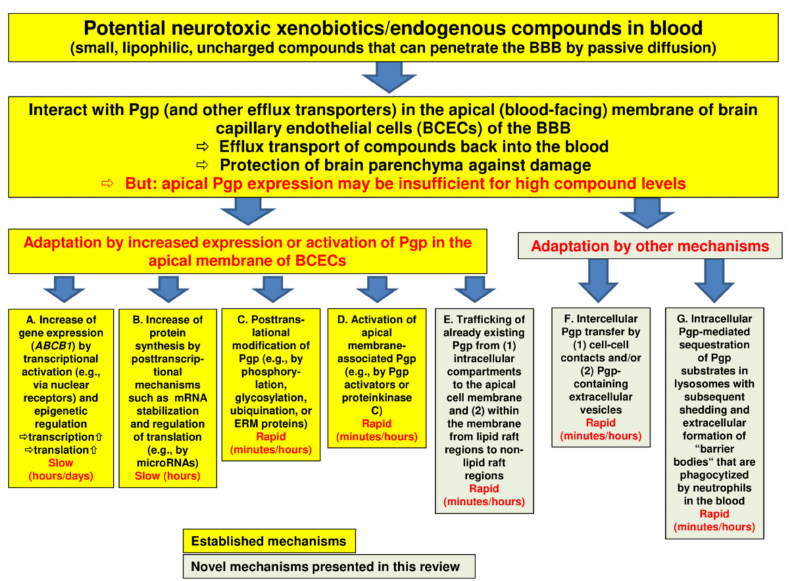
Figure 1. Regulation of P-glycoprotein (Pgp) expression and functionality at the blood-brain barrier. with the aim to protect the brain parenchyma from intoxication. The yellow boxes (designated by ( A – C )) show well-known mechanisms of Pgp adaptation (see Section 2), whereas the greenish boxes ( E – G ) illustrate the novel mechanisms that we characterized in brain capillary endothelial cells in recent years (see Section 3). Note that the mechanisms described in boxes ( A , B , F ) will increase the Pgp content of the cell, whereas the mechanisms described in boxes ( C , D , E ) and ( G ) will not. Although Pgp is the best characterized drug e ffl ux transporter at the blood-brain barrier (BBB), other transporters such as breast cancer resistance protein (BCRP) and multidrug resistance proteins (MRPs) are thought to support Pgp in its role to protect the brain (see Section 2.6). Indeed, the role of these other transporters is often underestimated, particularly in older